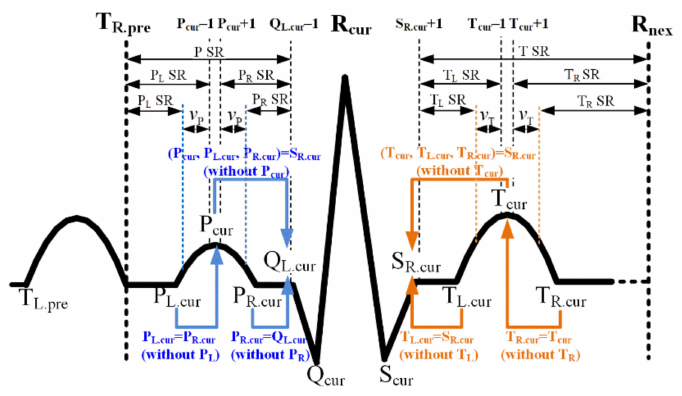
Figure 8. The SR for FP detection of P- and T-wave; Subscripts L, R, pre, cur, pre, and nex denote onset, offset, previous, current,